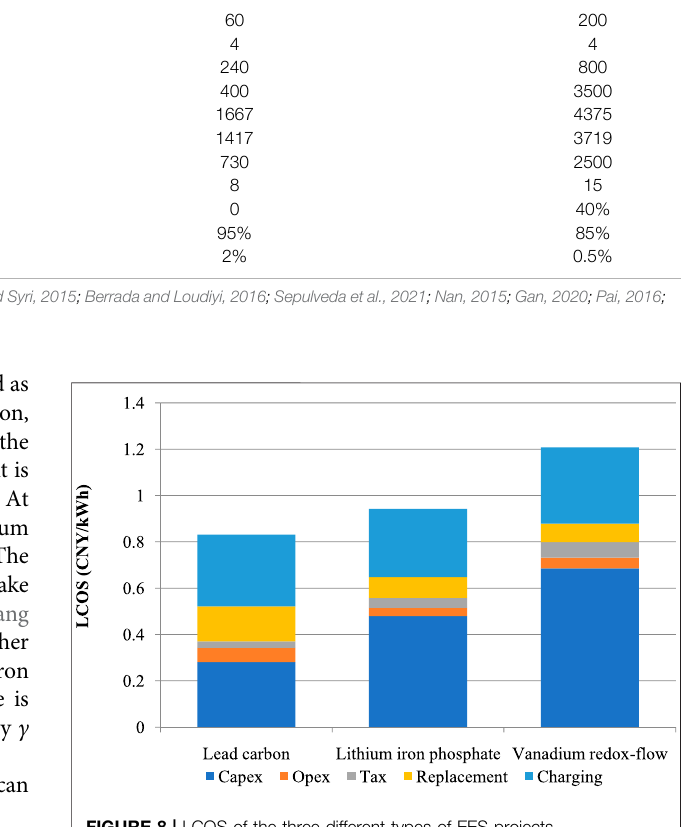
FIGURE 8 | LCOS of the three different types of EES